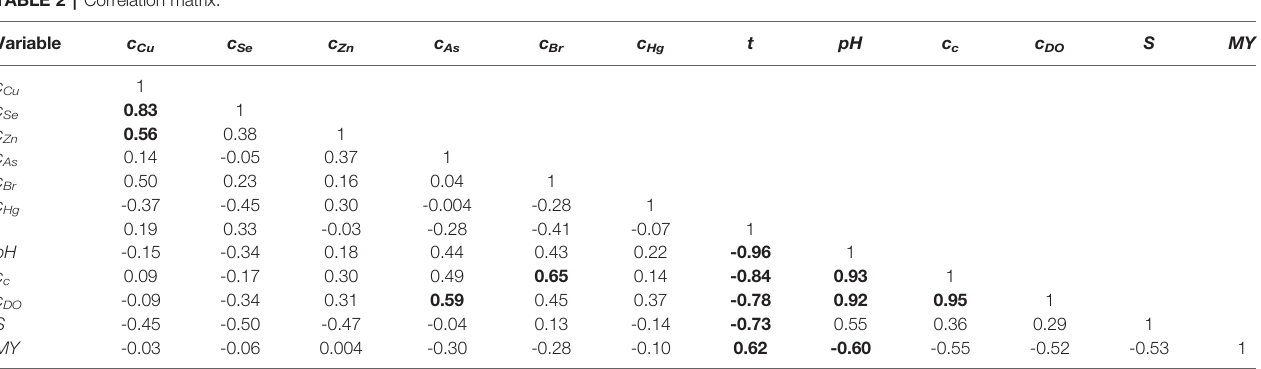
TABLE 2 | Correlation